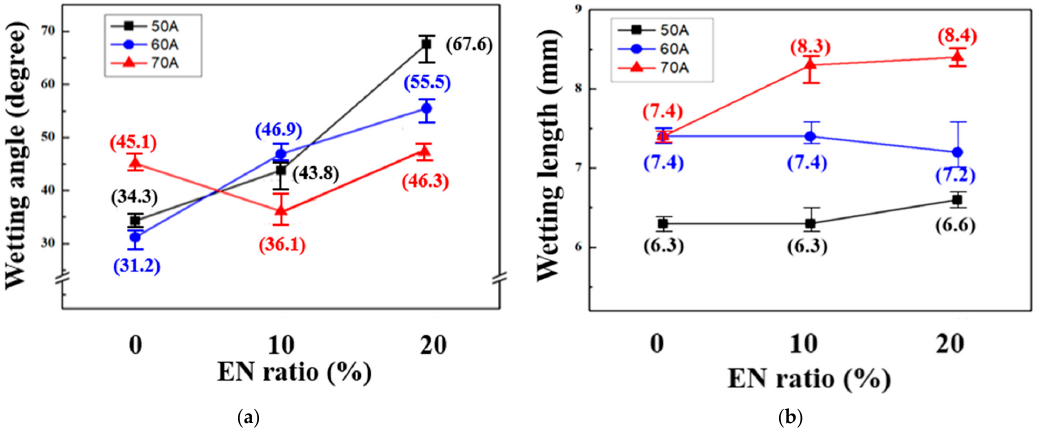
Figure 4. Comparison of wetting angle and wetting length with different welding currents and EN ratios: ( a ) wetting angle and ( b ) wetting length.